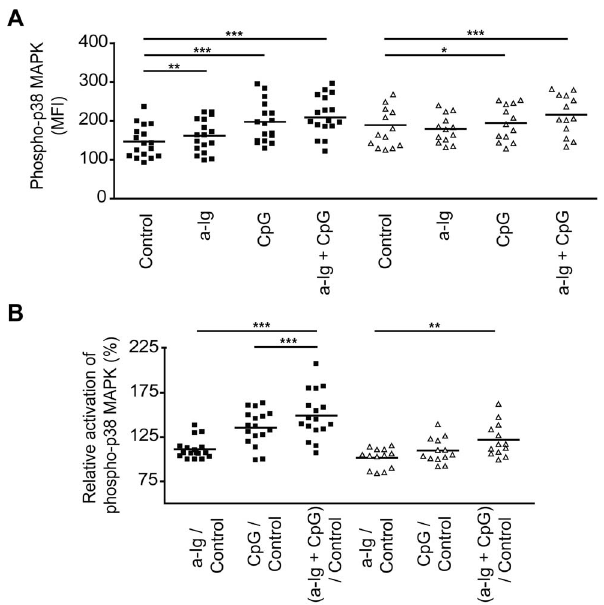
Figure 8. Phospho-flow analysis of p38 MAPK activation in resting and activated B cells from healthy blood donors and from RA patients. PBMC (4 6 10 6 cells) were left unstimulated (control) or stimulated with anti-Ig (7.5 m g/ml), CpG (4 m g/ml) or both agents for 30 min at 37 u C. p38 phosphorylation was tested in the CD19 + CD27 2 naive B cell subset. (A) The activation of p38 MAPK in healthy (square; n =17) and RA (triangle; n =13) B cells were analyzed by flow cytometry. (B) The relative activation of p38 MAPK was calculated based on the alteration of phosphorylated MAPKs expression in resting and stimulated naive B cells (stimulated sample MFI/resting sample MFI). Paired Student’s t-test was used to assess the differences of phospho- p38 MAPK expression between control and stimulated samples. * p , 0.05, ** p , 0.005, *** p , 0.0005.